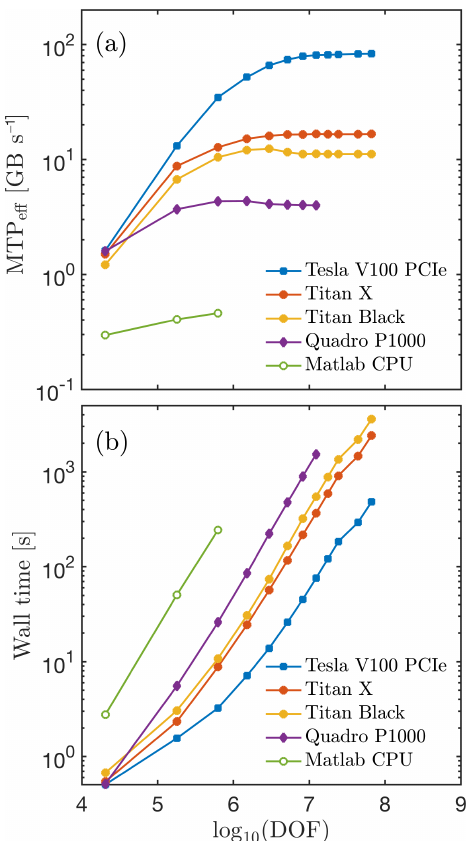
Figure 18. Performance evaluation of the FastICE mechanical solver in terms of (a) effective memory throughput MTP eff in GB per second and (b) wall time (in seconds) to converge the Stokes solver to a relative non-linear tolerance of tol nonlin = 10 − 8 . We re- port the results from a 3-D CPU-based single-core vectorised MAT- LAB implementation and a 3-D GPU-based CUDA C implemen- tation of FastICE running on different GPU chip architectures. The CPU codes are executed on an Intel i7 4960HQ CPU processor with 8GB of RAM. The GPU codes were launched on a Nvidia Titan Black (Kepler) GPU with 6GB, a Nvidia Titan X (Maxwell) GPU 12GB, a Nvidia Quadro P1000 (Pascal) 4GB and a Nvidia Tesla V100 PCIe (Volta)